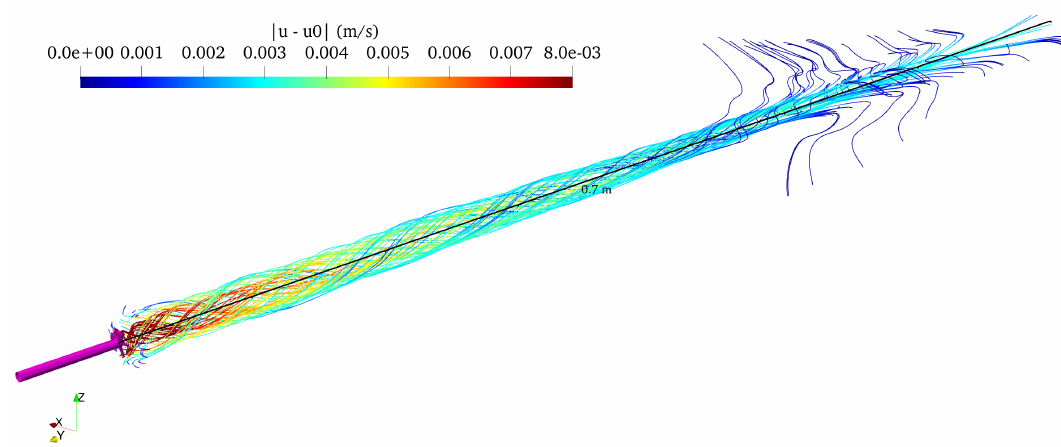
Figure 4. Streamlines of the flow speed perturbation downstream of the propeller at t = 200 s. One hundred streamlines are shown. This illustrates the swirl generated by the propeller and the spreading of the streamlines further downstream where the mixed patch is collapsing. The streamlines extend up to 0.7 m downstream of the propeller’s hub (i.e., up to y = domain is not shown. The streamlines were terminated if The propeller system is coloured